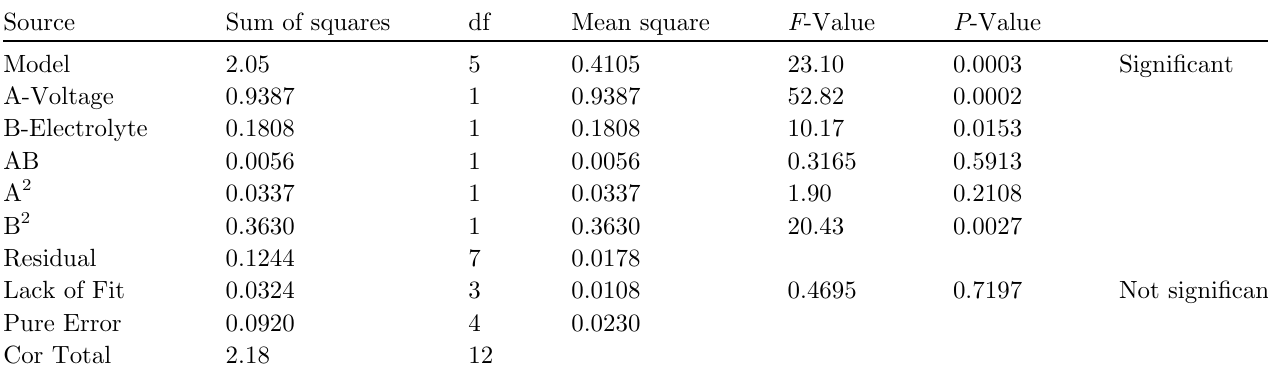
Table 6. Analysis of variance for machined depth.